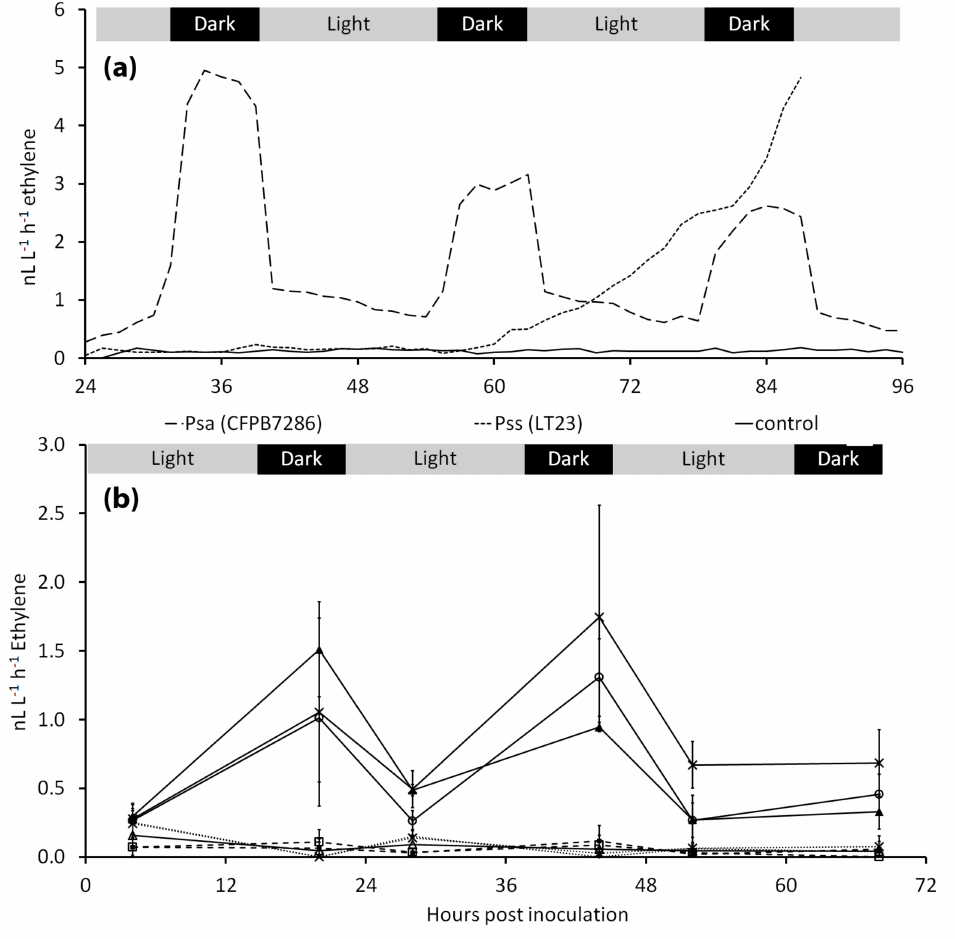
observed and was limited to the dark phase of the photoperiod. Plants release ethylene starting from 60 h after inoculation with an Actinidia -pathogenic P. syringae pv. syringae strain, but no diel pattern was observed in this case (Figure 8a). Ethylene emission was induced only by the ethylene producing strains belonging to biovar 3 (CFBP7286, 10,787 and Arg2.1), whereas plants inoculated with the ethylene deficient strain CFBP7286- ∆ bep did not emit ethylene (Figure 8b). At the end of the experiment, 5 days after inoculation, no differences in endophytic bacterial populations were observed among plants inoculated with different Psa strains (data not shown).